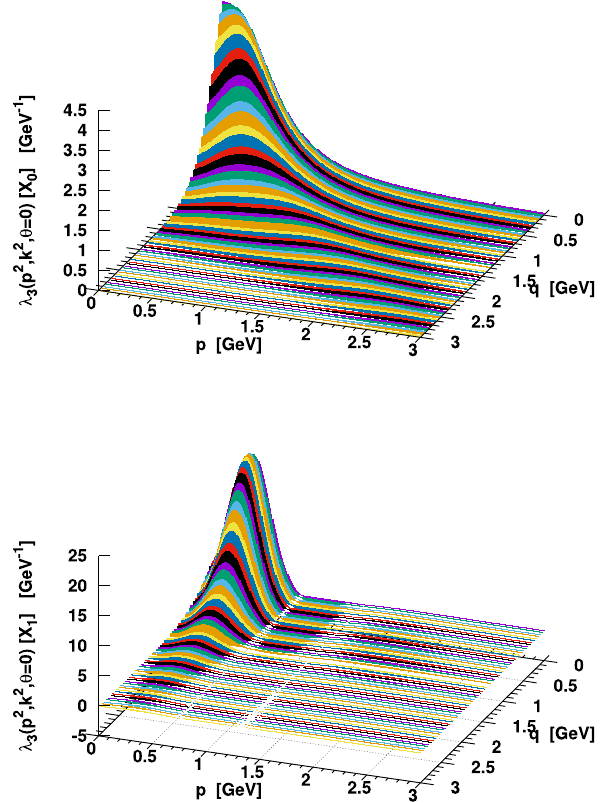
Fig. 8 The contribution proportional to X 0 (left) and to Y 1 to the form factor λ